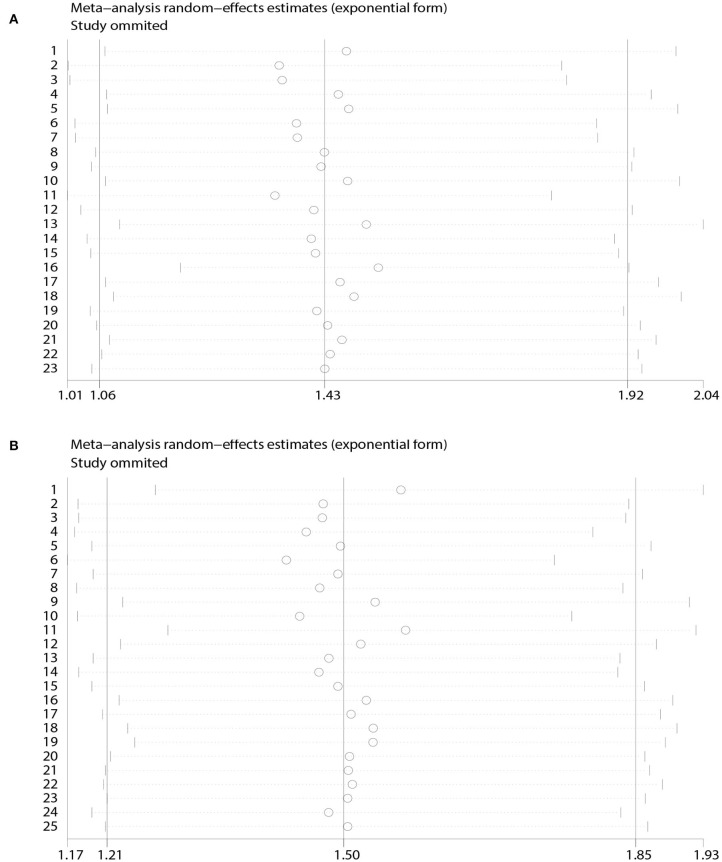
Sensitivity analyses based on (A) overall survival; (B) disease-free survival.